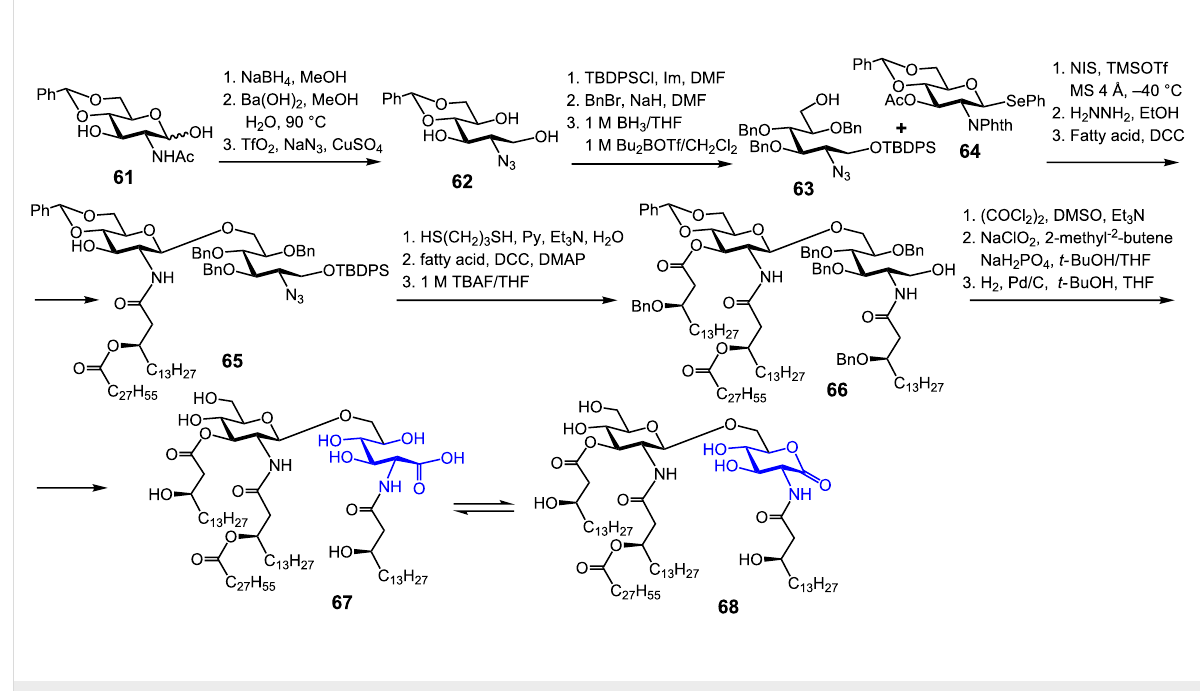
Scheme 8: Synthesis of tetraacylated Rhizobium lipid A containing aminogluconate